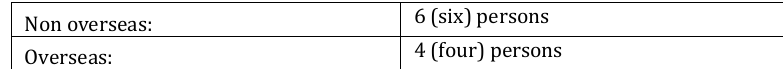
Table 3 Works Experiences in Overseas (Other than in